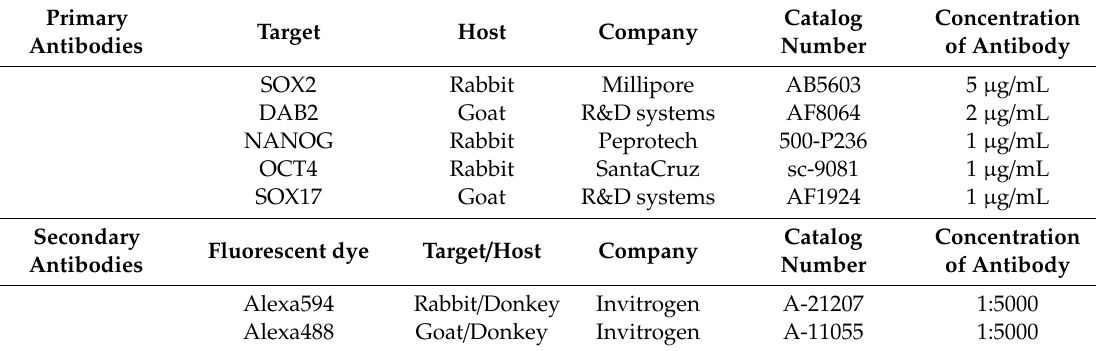
Table A2. List of